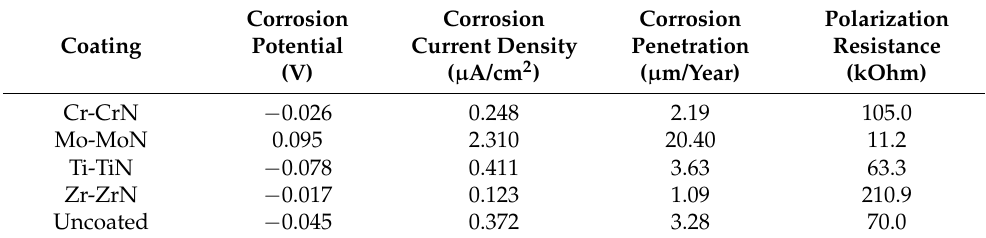
Table 6. Calculation results of the corrosion process characteristics using the method of determining the polarization resistance in the region of the corrosion potential in the 3 wt.% aqueous solution of NaCl at the temperature of 25 ◦ C.